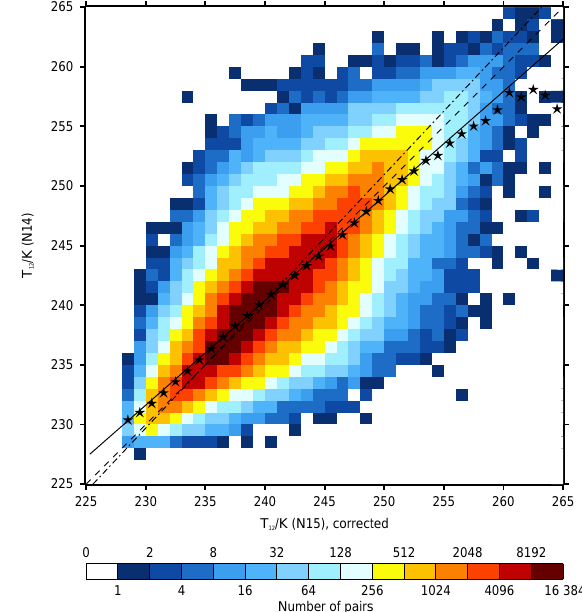
12 (N15) with the cdf- based procedure described in the text. The gravity centre of the joint distribution (dark-red pixels) is now following the diagonal axis (dashed black line); however, both regression lines, the ordi- nary least squares (solid) and the bivariate (dash-dotted), are tilted against the diagonal. Marginal means of T 12 (N14) for each 1K interval of the corrected T 12 (N15) are represented by stars; they again closely resemble the ordinary least squares linear regression. The tilt between the ordinary least squares fit and the diagonal is smaller than in Fig. 2, which means that the cdf-based correction brings T 12 (HIRS 3) levels closer to T 12 (HIRS 2)